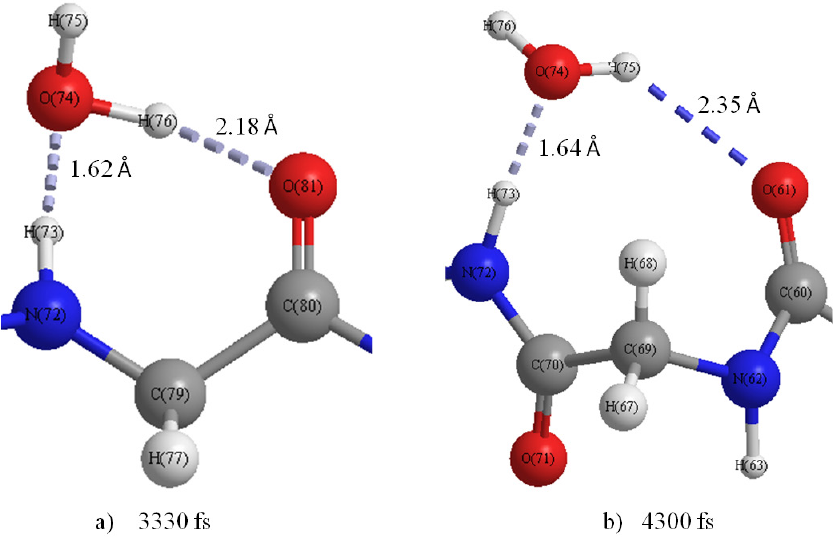
region at ( a ) 3330 fs and ( b ) 4300 fs. 1